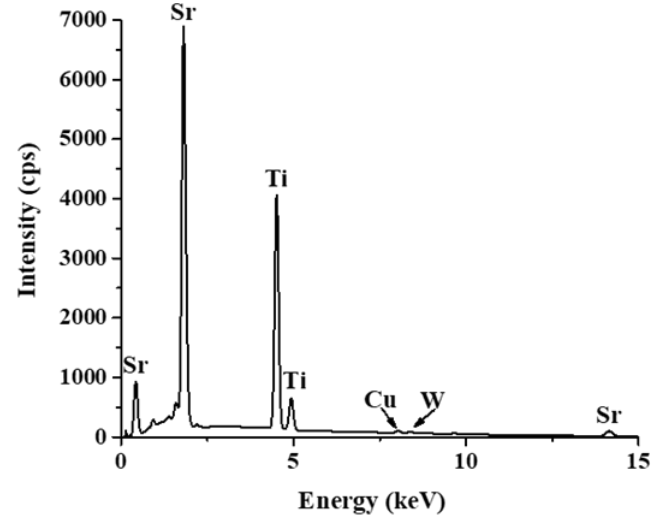
Figure 5. Representative EDX spectrum of the CWS3 sample.